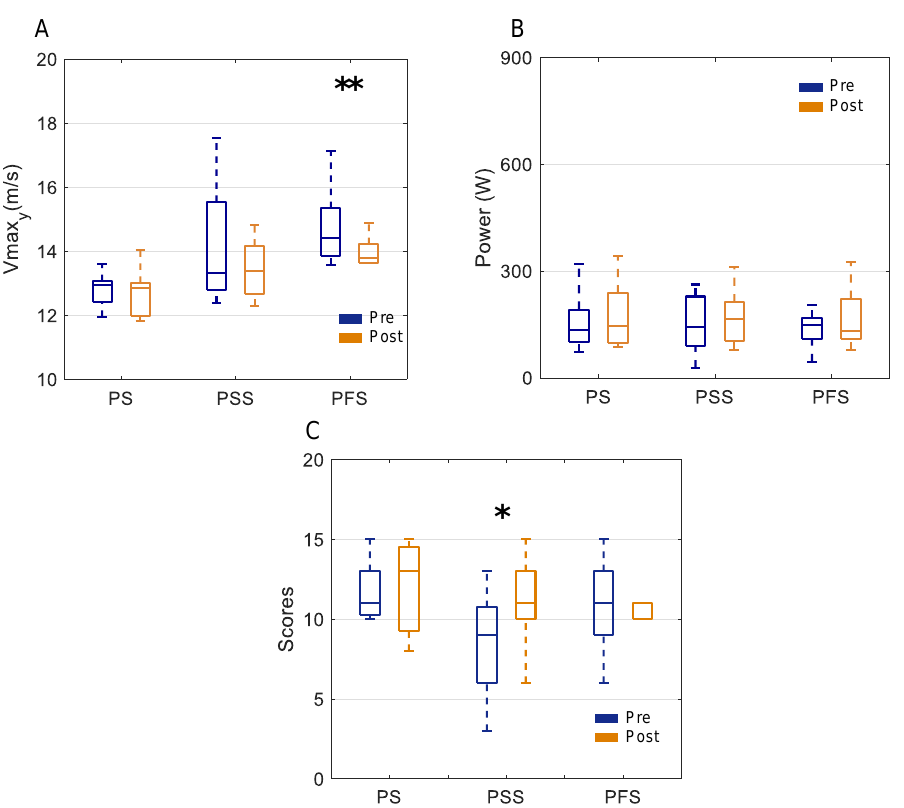
Figure 4. Boxplots showing the median and IQR of the shoulder ( A ) and elbow ( B ) angles calculated before and after the training program. PS: penalty shot; PSS: passing-spontaneous shot; PFS: pass- ing-feint shot. Statistically significant differences between the Pre and Post conditions are high- lighted with asterisks (** represents a p -value < 0.01).